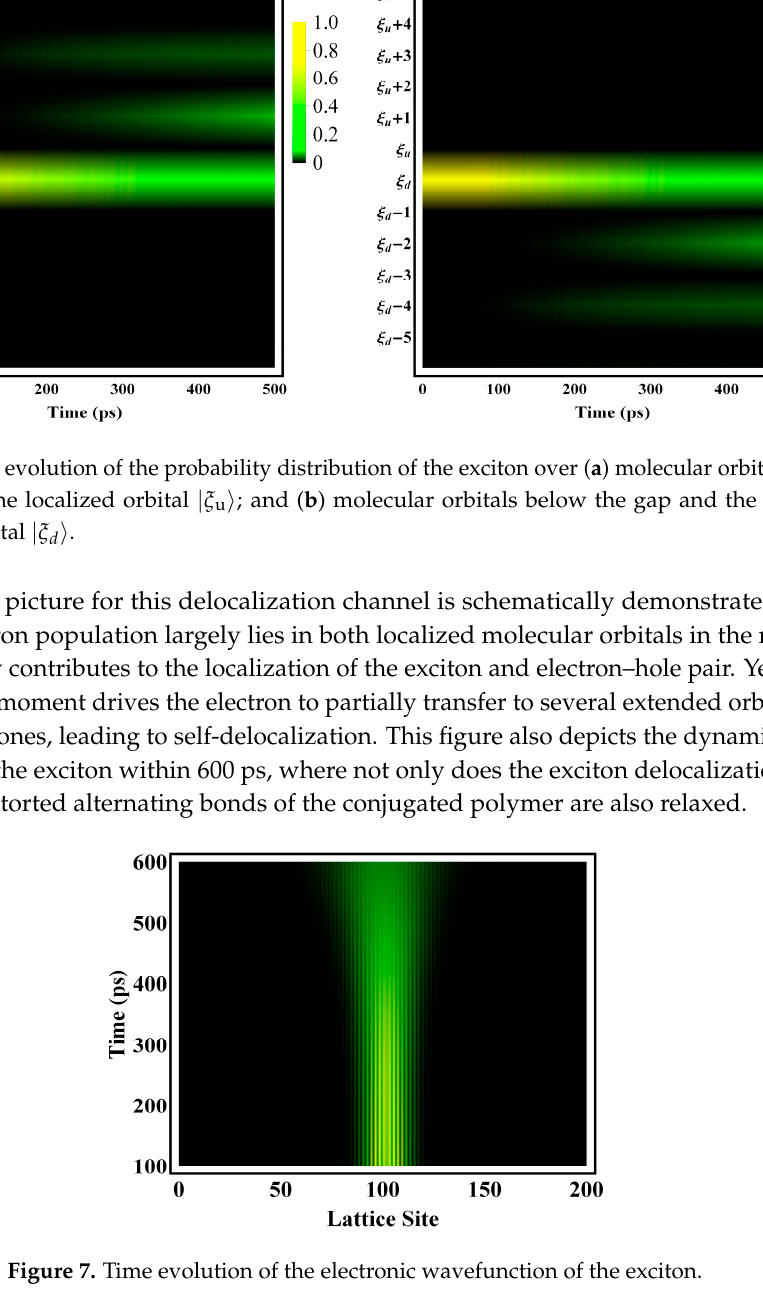
Figure 7. Time evolution of the electronic wavefunction of the exciton.